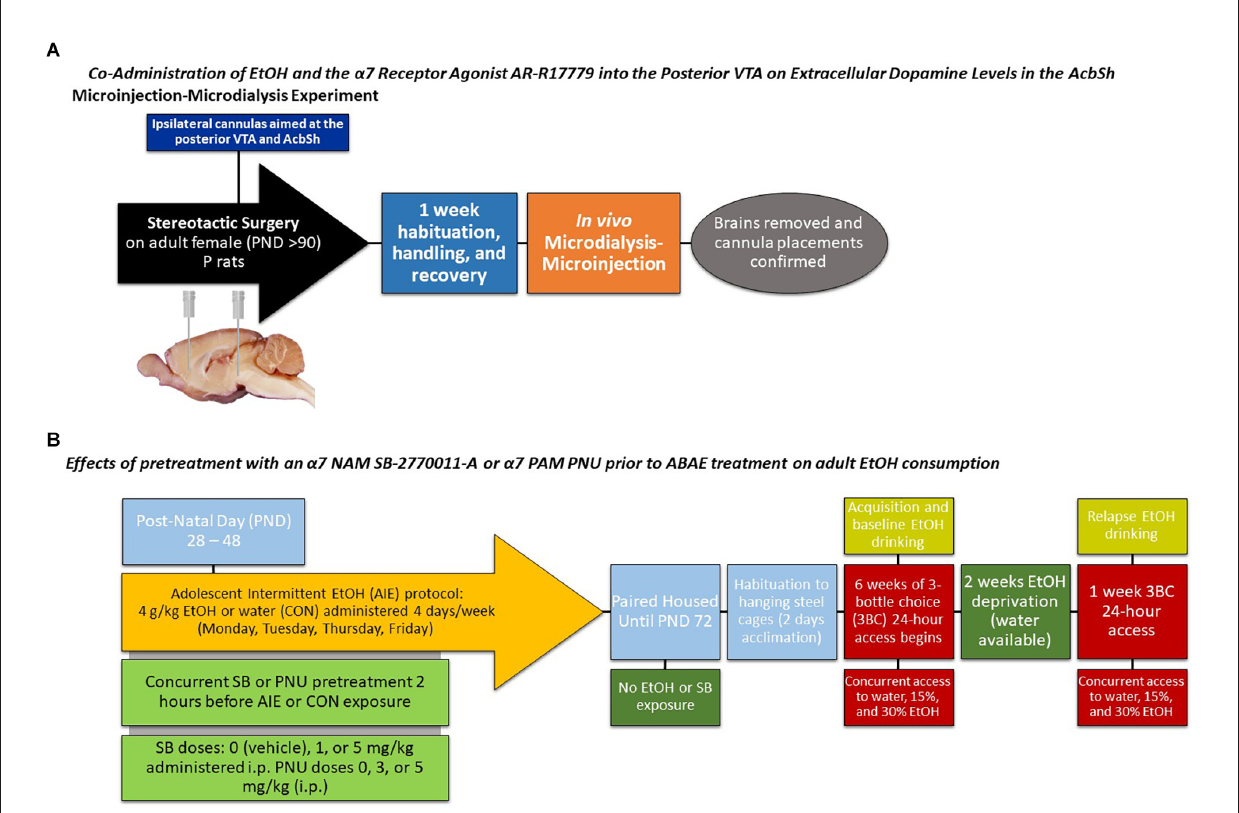
FIGURE1 Depicts a timeline for the (A) microinjection-microdialysis experiments and (B) adult alcohol intake